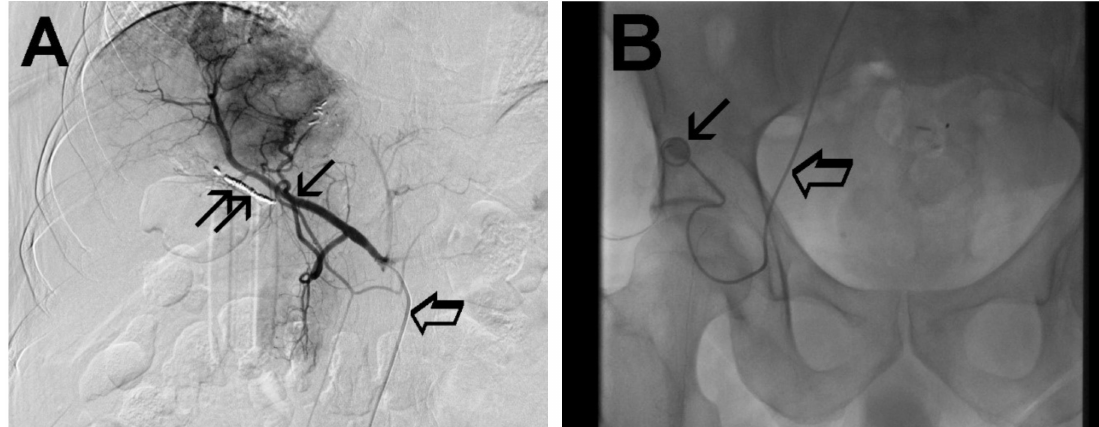
Figure 2. The arterial phase of the contrast angiogram shows the subcutaneous port and the hepatic-artery catheter ( A .) The arterial phase of the contrast angiogram shows the hepatic-artery (thin arrow), the preparation of the vascular bed (double thin arrow) and the hepatic-artery catheter (large arrow). ( B .) The arterial phase of the contrast angiogram shows the subcutaneous port (thin arrow) with its connection system and the hepatic-artery catheter (large